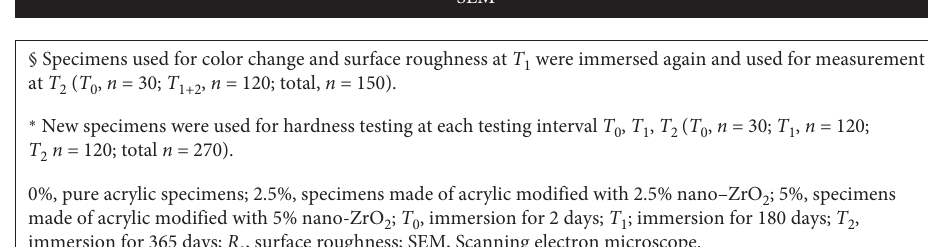
Figure 1: Flowchart of specimen immersion and